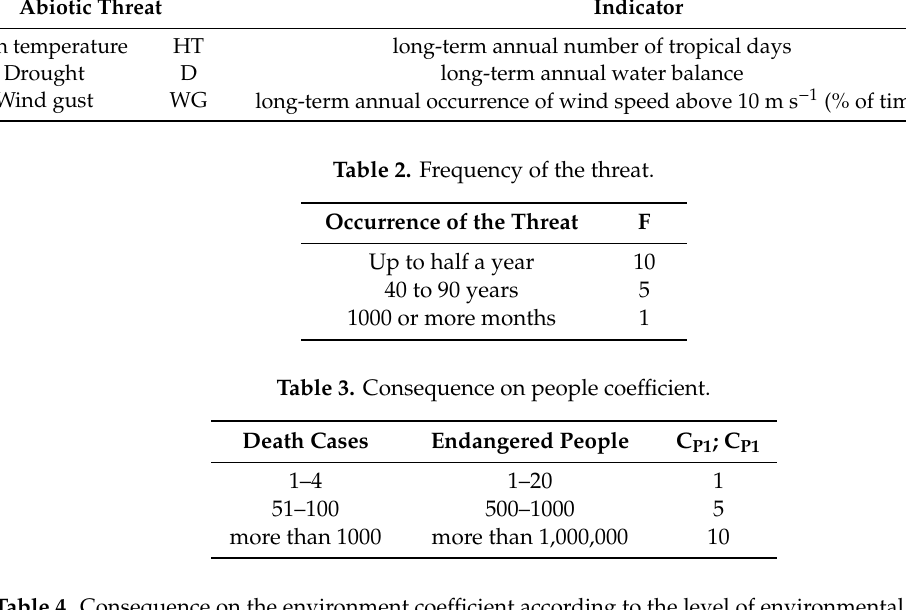
Table 4. Consequence on the environment coe ffi cient according to the level of environmental damage.